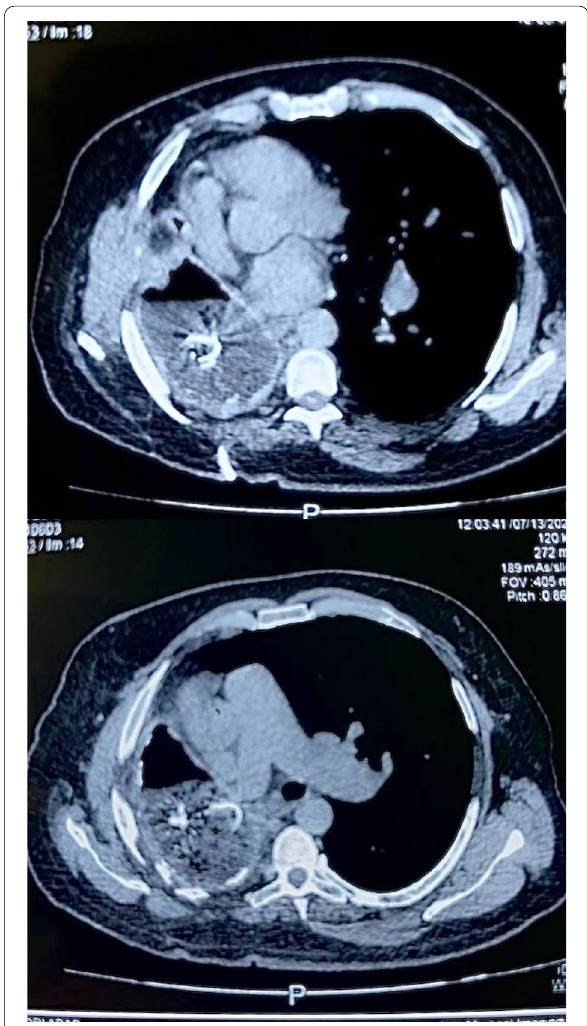
Fig. 2 Axial thoracic CT scan showing gossypiboma in occupying right hemithoracic